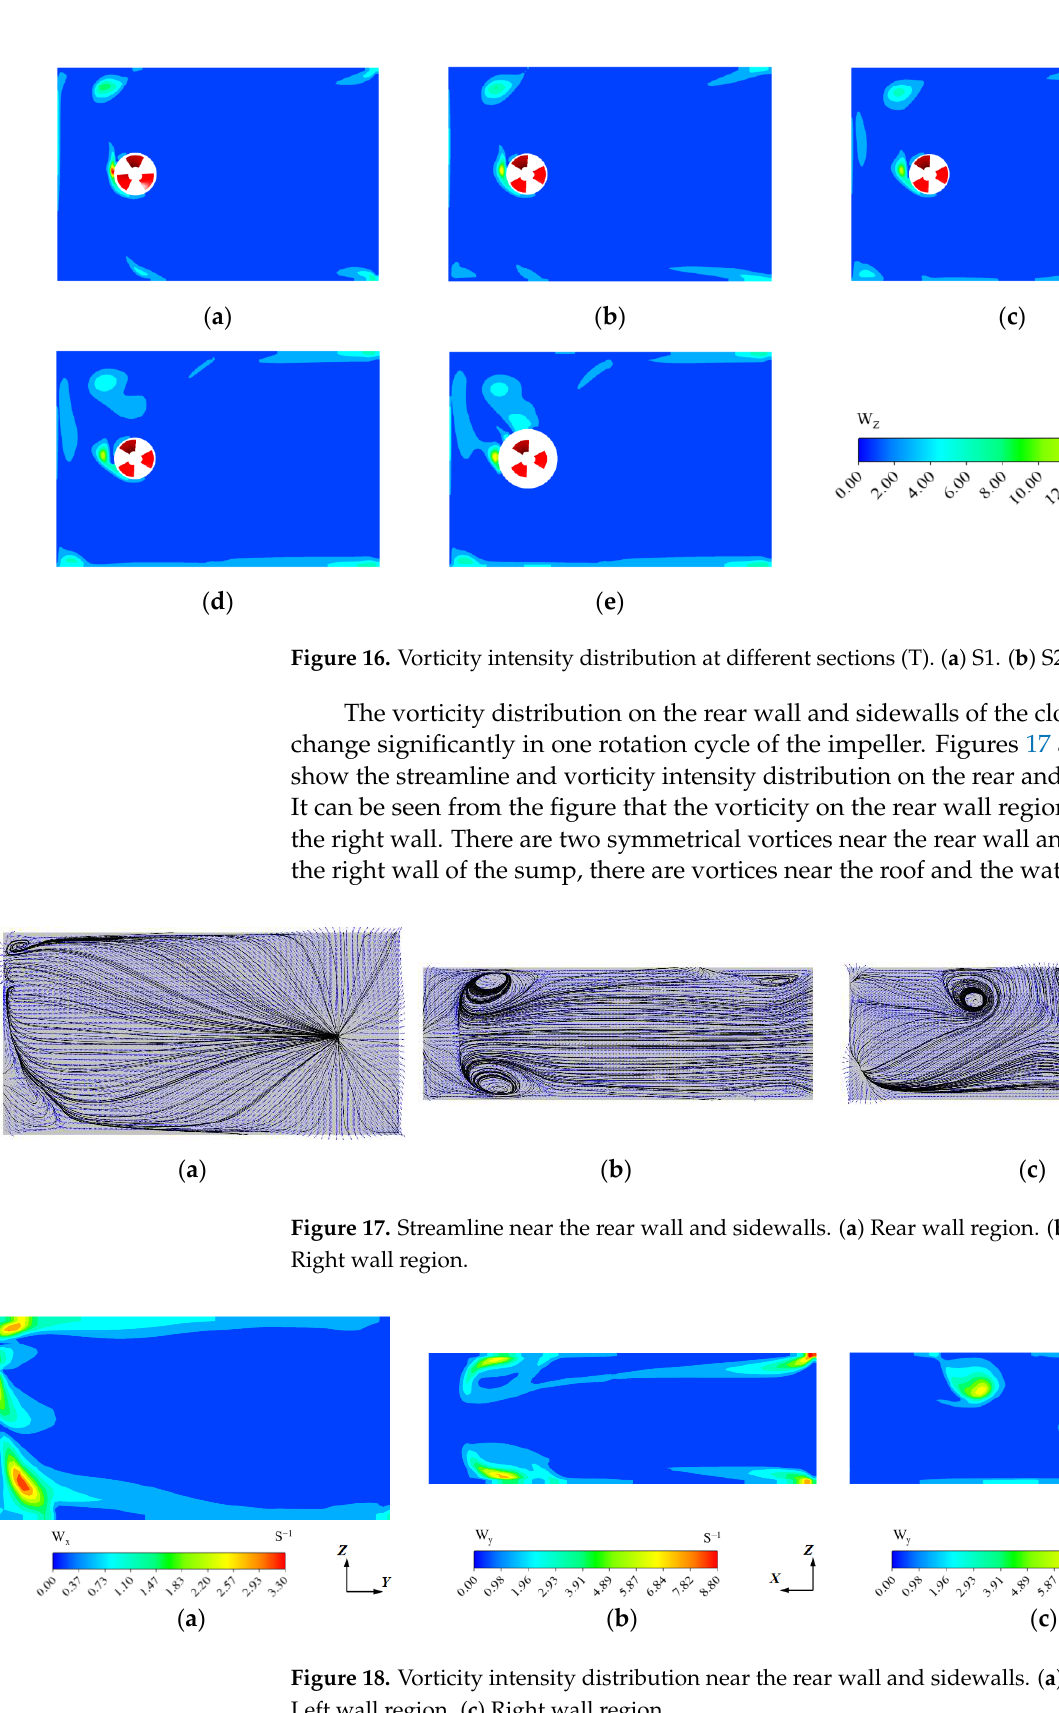
Figure 15. Five axial section positions.